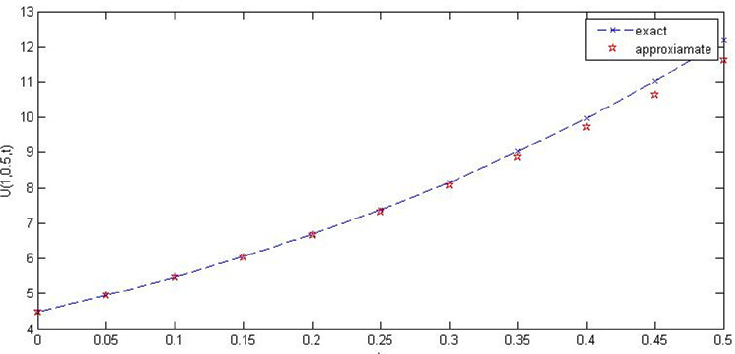
Figure 1. Exact solution and third approximate solution for α =